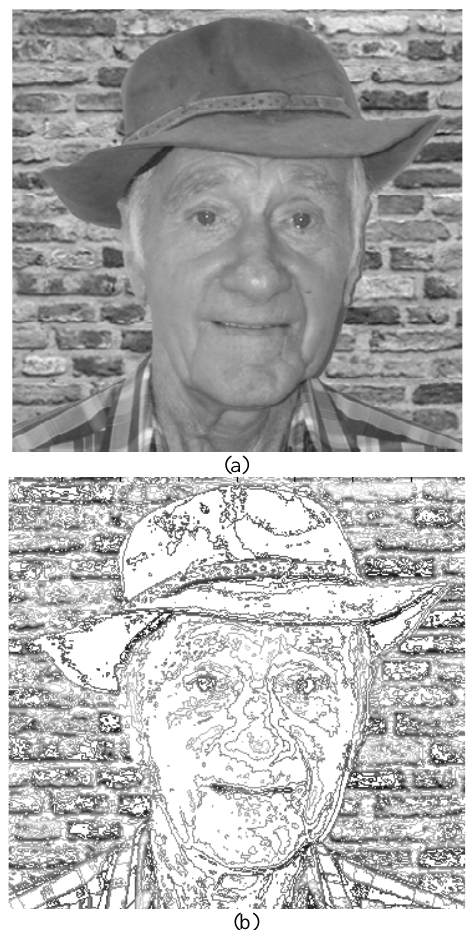
Figure 1. (a) The original image of Peter . tif is a contour representation of (a) for contour 8 grey-scale